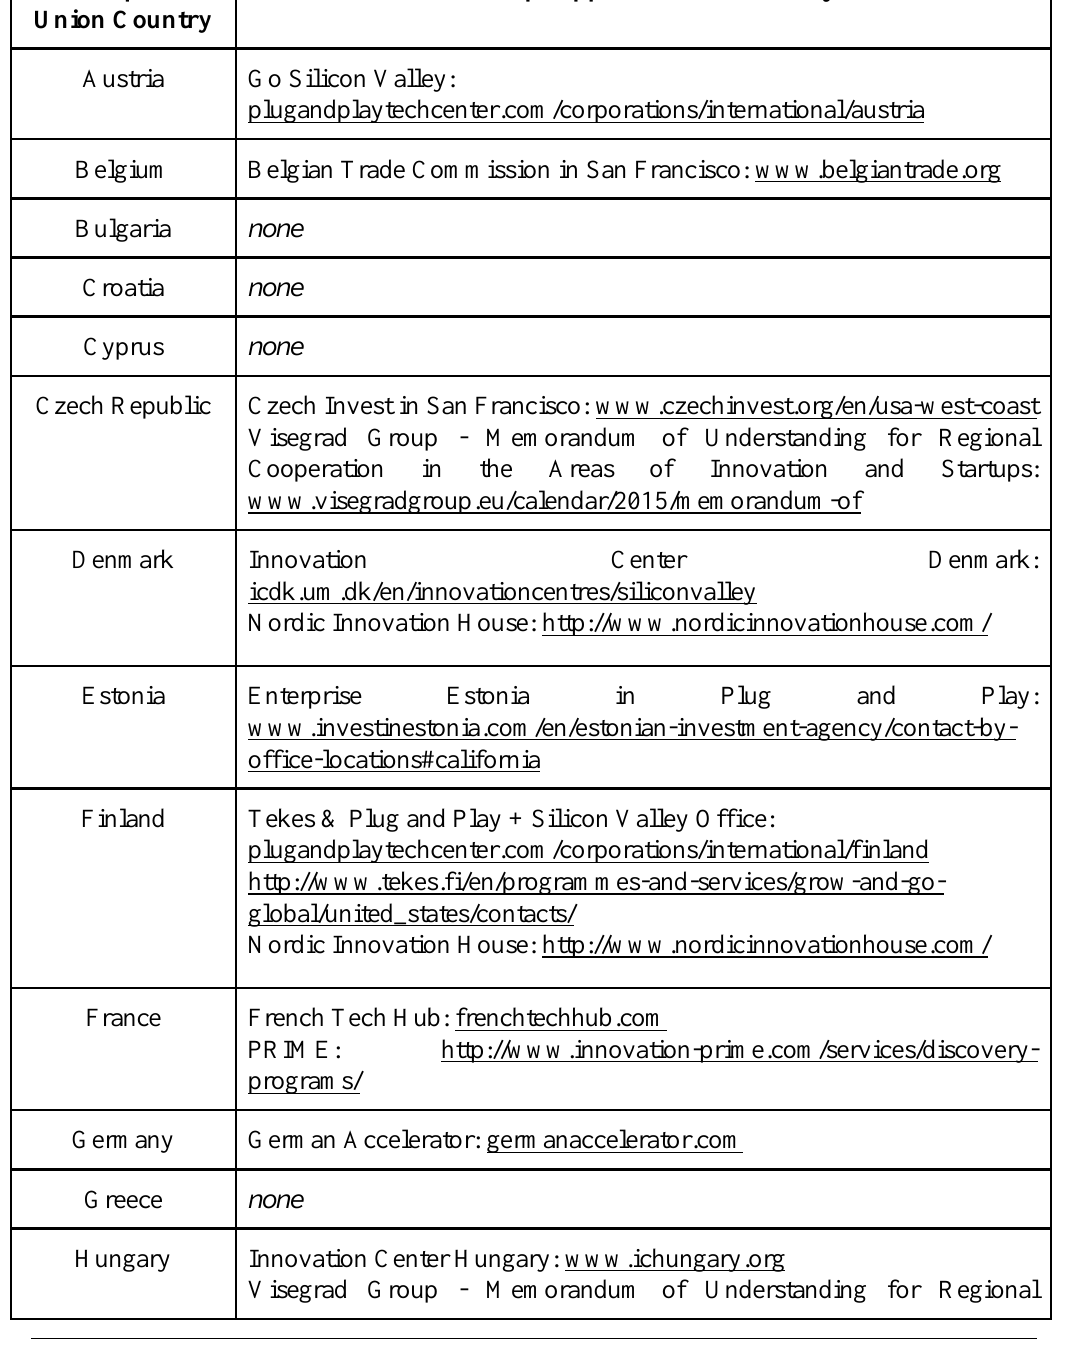
Table 1: Startup support in Silicon Valley European Union